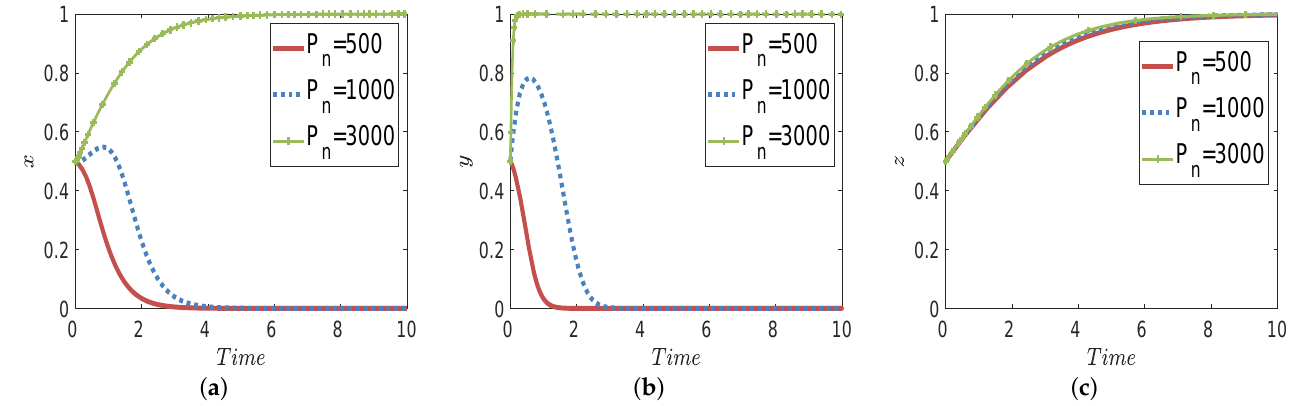
Figure 9. The impact of P n on evolution: ( a ) crowd workers; ( b ) crowdsourcing platforms; ( c ) task